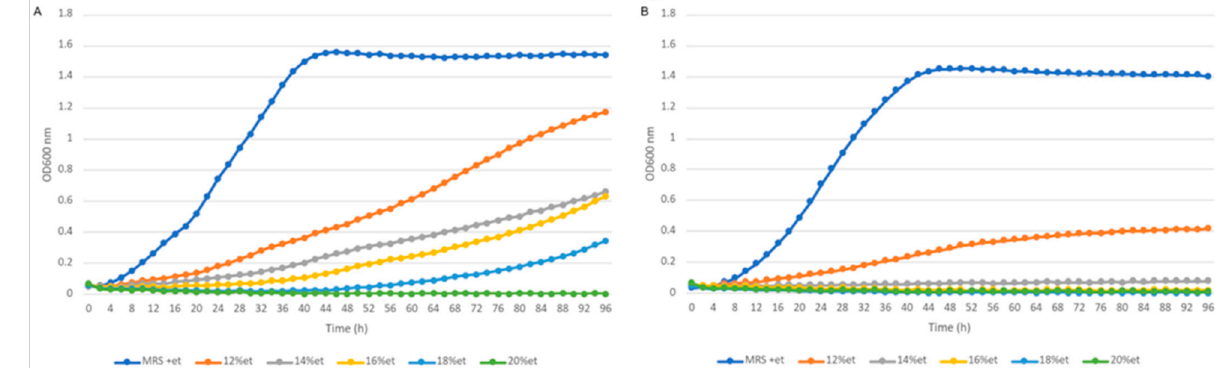
Figure 8. Growth curves of L. hilgrardii FLUB ( A ) and L. hilgardii DSMZ ( B ) on a medium supplemented with 12–20% ethanol, and control